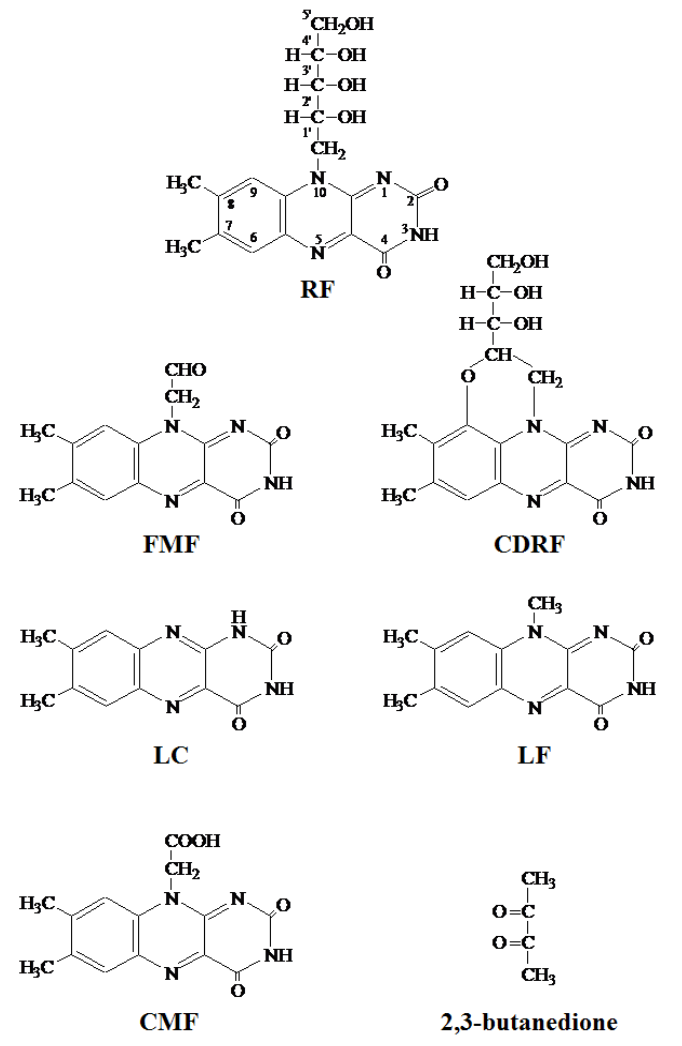
Figure 1. Structures of RF and its